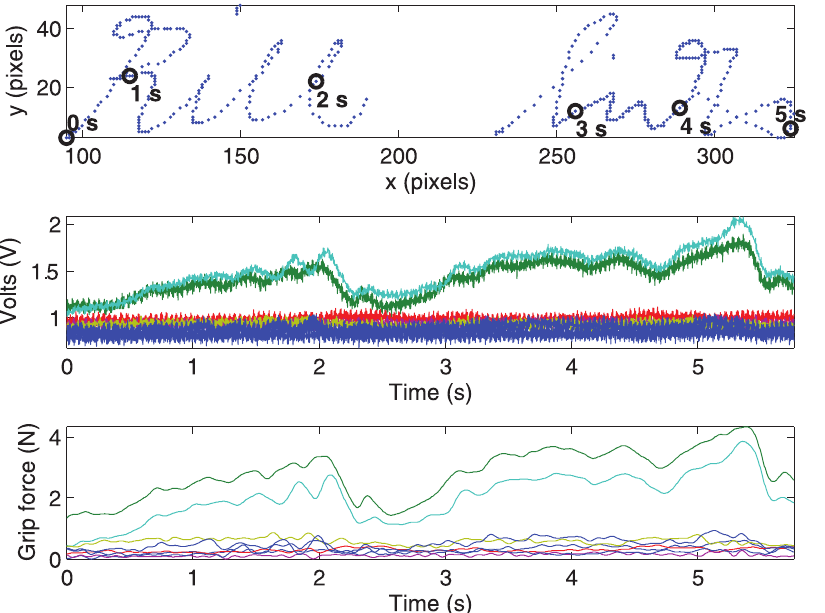
Figure 3. A signature example and the associated grip force signals. The top graph shows the position signals of a signature sample annotated at 1 second increments, and the middle and bottom graphs show the associated raw and processed grip force signals respectively. For clarity, only the non-zero force traces are shown in the latter. In bottom two graphs, each line represents the readout of a different grip sensor. Note that this sample is not an authentic signature; it is a sample of a well-practiced